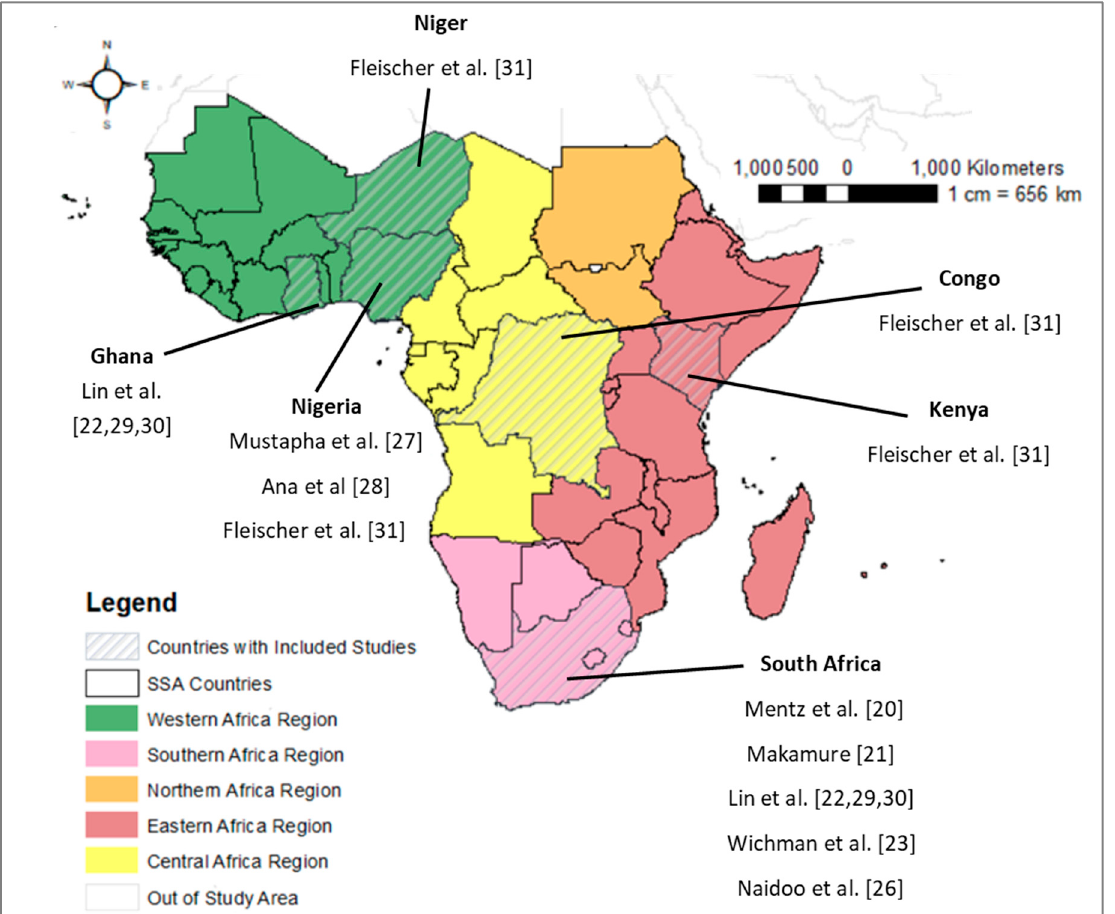
Figure 1. Map of study area and locations of individual ‐ level AAP epidemiology studies. Countries with individual ‐ level AAP epidemiology studies are indicated with diagonal grey lines and the respective study author and citation number provided for each studied country.